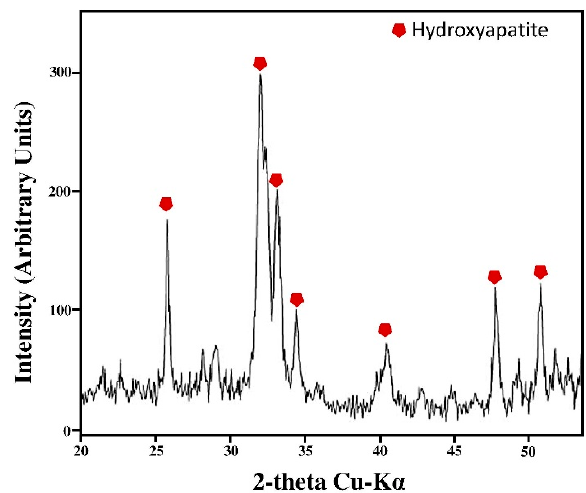
Figure 8. A representative x-ray diffraction (XRD) spectrum of the crystalline hydroxyapatite layer on the EXT0.5 thread surface after soaking in SBF solution for 21 days.